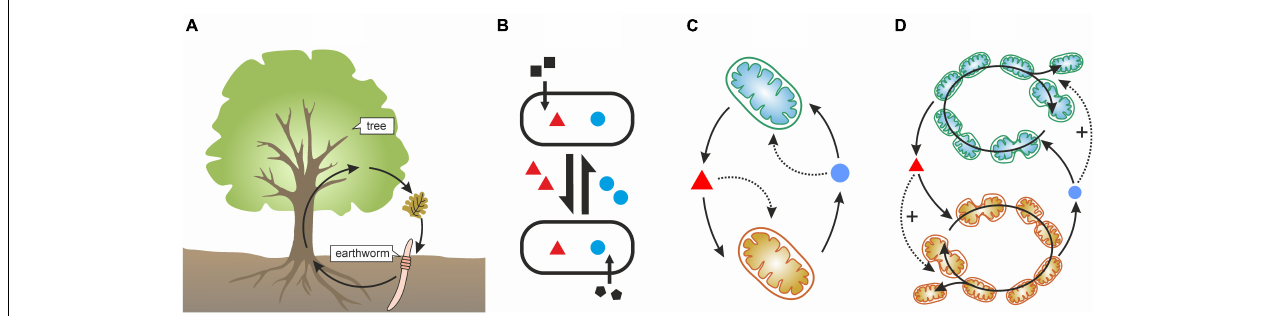
FIGURE 1 | Different representations of ecological interactions. (A) An ecological hypercycle between two organisms [from Maynard Smith and Szathmáry (1995), p.58]. This example is deliberately confusing: without further specification, arrows could represent purely trophic interactions, cooperation, or both. It is also not immediately apparent if there is any auto or cross-catalysis going on. Clearly, a better representation is required to give a full account of the relevant interactions. (B) Bidirectional cooperative cross-feeding with reciprocal exchange of a costly metabolite (red triangle, blue disk) that benefits both partners, as depicted in D’Souza et al. (2018). Note, that neither the cost, nor the benefit (cooperative act) is obvious without additional information. As a matter of fact, arrows could simply indicate the transformation of matter without any cooperative aid. (C) A more accurate representation of a syntrophic interaction: normal arrows indicate production and consumption, dotted arrows indicate cooperative benefit (catalytic aid). (D) A more precise representation of syntrophy with reproduction made explicit: benefit is only cooperative if it enhances the growth of the receiver, that is, it feeds back positively on its